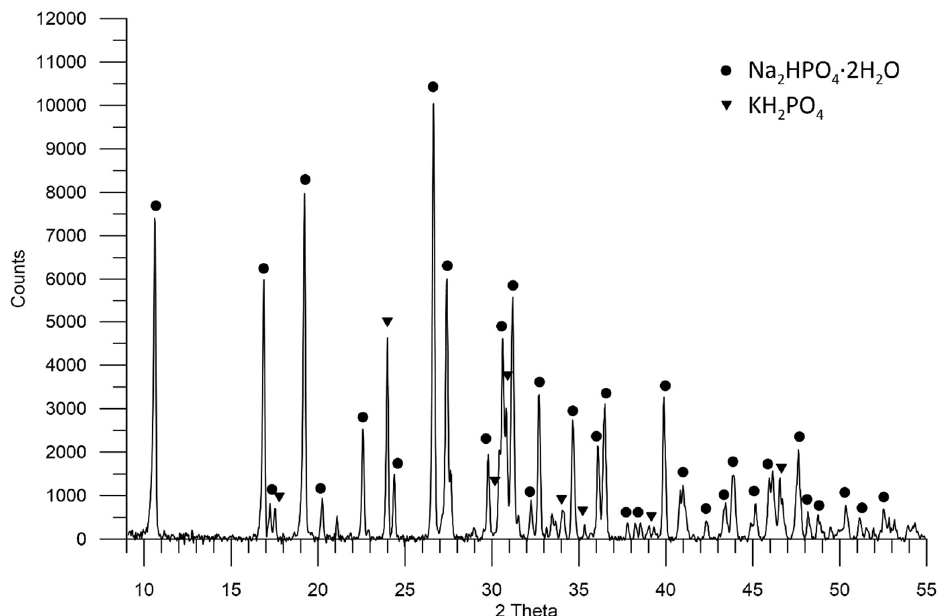
Figure 3. A diffractogram showing the composition of sediment 2 in the sample of waste phosphate from polyol production.